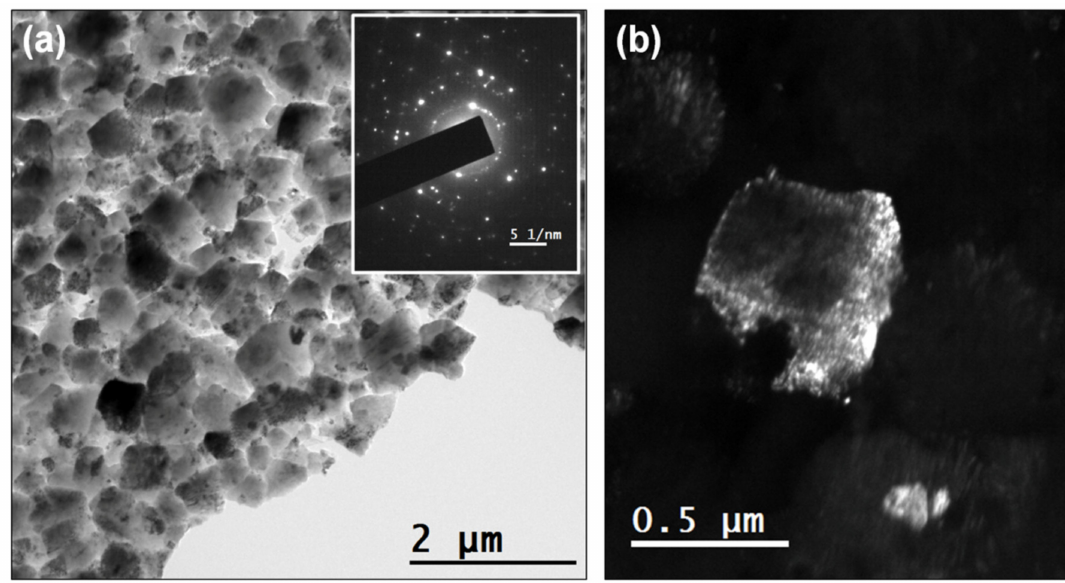
Figure 4. ( a ) Bright field (BF) TEM micrograph of sample grown with 0.2% N 2 . The inset of ( a ) shows the SAED pattern using an aperture with 1 µ m diameter. ( b ) Dark field (DF) micrograph of one reflection that shows one of the grains with good contrast.